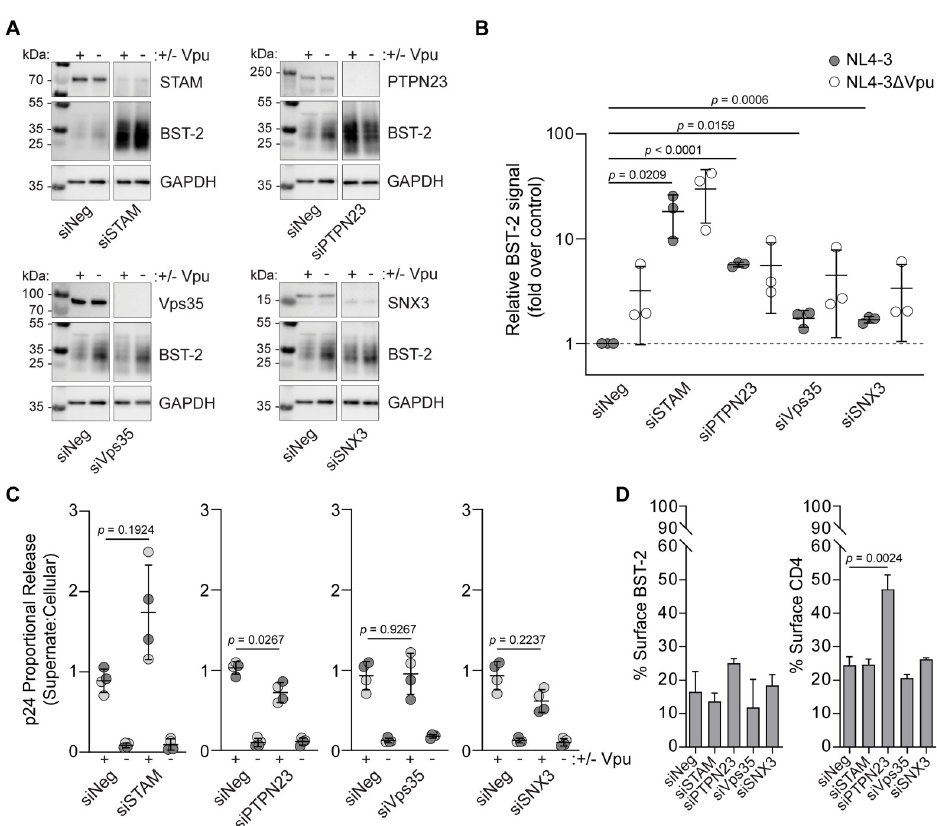
Fig 9. Cofactors required for Vpu activities. Candidate cofactor proteins were transiently depleted using siRNAs in HeLa P4.R5 cells. The cells were transfected with pNL4-3 (an HIV proviral plasmid expressing the complete viral genome including Vpu) or pNL4-3 Δ Vpu 48 hours later. The cells were lysed 24 hr post-transfection and BST-2 was probed by SDS-PAGE and western blotting. (B) BST-2 signals were measured relative to loading control (GAPDH) and presented as fold signal over NL4-3 (negative control siRNA; Vpu-expressed). Data are the mean +/- SD of three independent experiments, the p -value was determined by Student’s t -test. (C) Cofactors affecting virus release. Candidate cofactors affect virus release. Candidate cofactor proteins were transiently knocked-down using siRNAs in HeLa P4.R5 cells 48 hr prior to transduction with VSV-G-pseudotyped Δ Env HIV (dHIV) or dHIV Δ Vpu at MOI 0.1. Cell-free and cell-associated virus (p24) was measured 24 hr later. Data are expressed as p24 in the supernate proportional to cell-associated p24, i.e. proportional p24 released from the cells. Data are mean +/- SD of two independent experiments, with duplicate wells measured in each experiment. Data points are colored according to experiment. The p -value was determined by Student’s t -test. (D) Cofactors affecting surface BST-2 and CD4. HeLa P4. R5 cells transiently depleted of the candidate cofactors by siRNA-knockdown were transfected to express Vpu-FLAG or empty plasmid control, and GFP. BST-2 and CD4 levels at the cell surface were measured by immunofluorescence staining and flow cytometry 24 hr later. Surface levels of BST-2 and CD4 on cells expressing Vpu were expressed as the % of control cells not expressing Vpu. Error bars represent standard deviation of n = 2 experiments, p -value determined by Student’s t